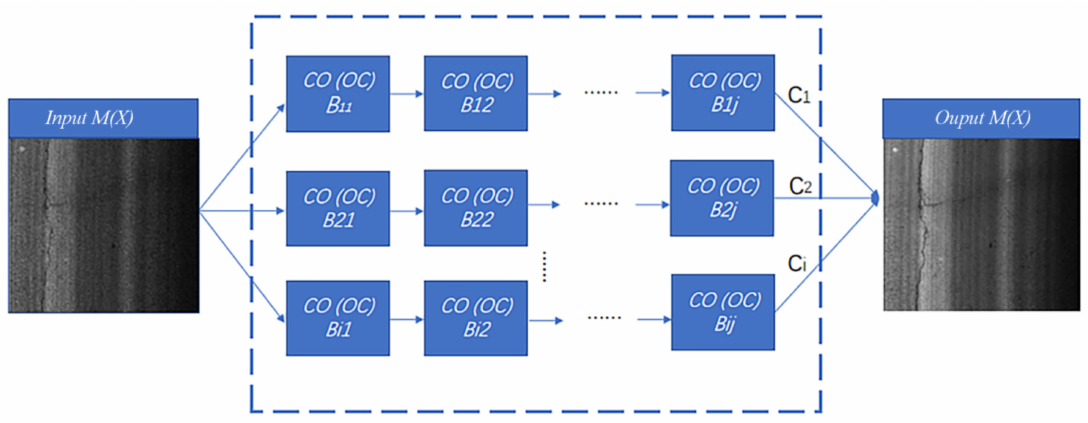
Figure 4. The composite filter for image